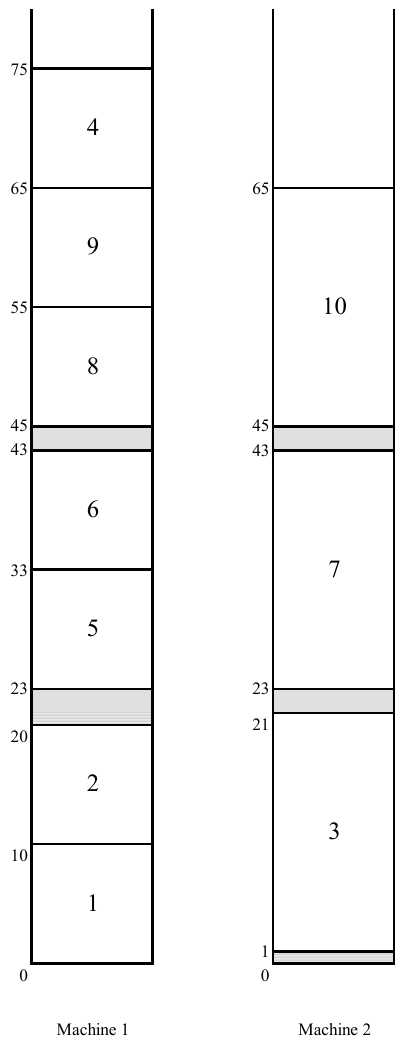
Figure 3. The C-schedule σ 4,4